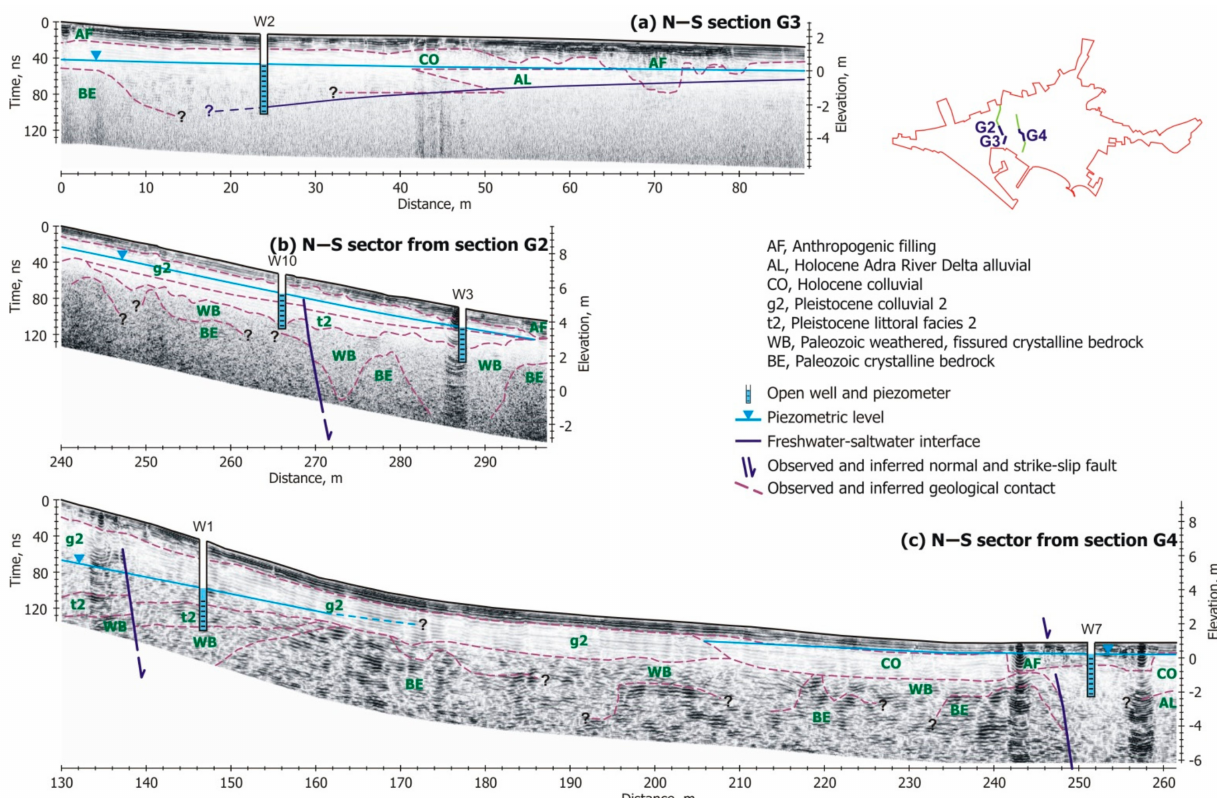
Figure 5. Selected sectors from GPR sections G2, G3, and G4 of especial hydrogeological interest; location is in Figure 2. The interpretation of radargrams was based on previous geological [19] and hydrogeological [15] data, and MASW sections (Figure 3). The projected piezometric level after the flash campaign carried out in June 2015 is included; location of open well and piezometer W1, W2, W3, W7, and W10 is in Figure 2. Profiles are topographically corrected and its vertical-to-horizontal scale ratio is